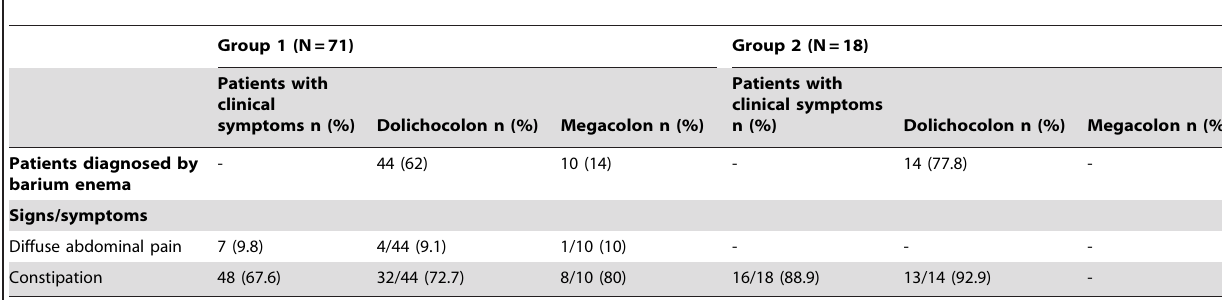
Table 5. Colonopathy: Clinical findings and barium enema